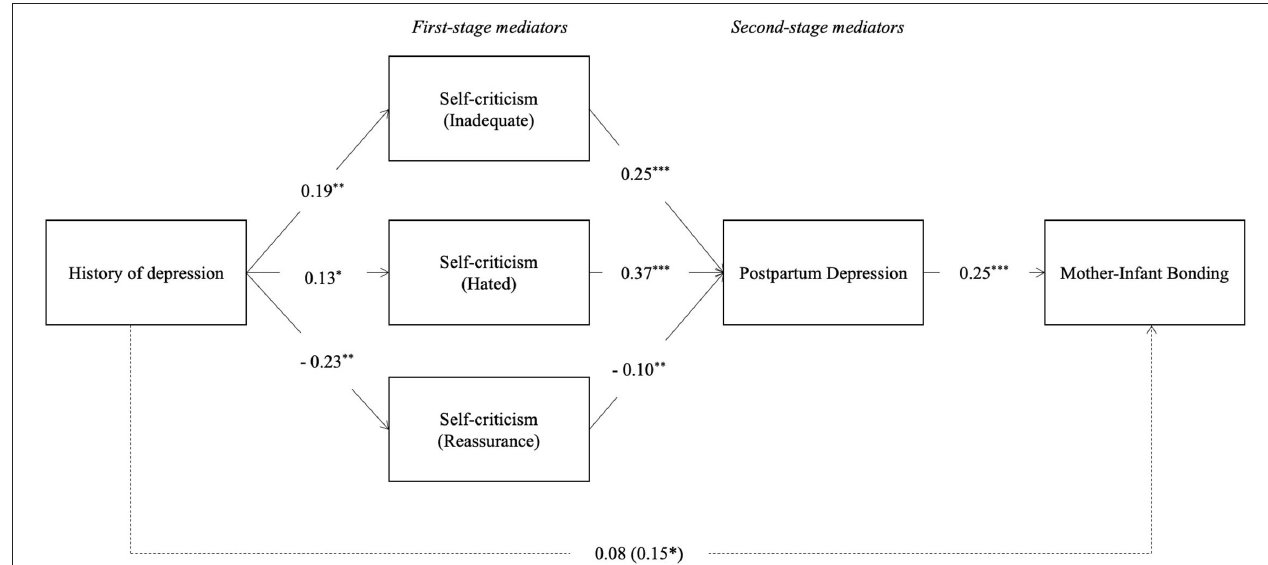
FIGURE 3 | Serial–parallel mediation model with standardized path coefficients: History of depression symptoms, inadequate-self, hated-self and reassuring-self dimensions of self-criticism, PPD Symptoms and mother–infant bonding (M1). * p < 0.05, ** p < 0.01, *** p < 0.001. The coefficients of the total effects appear in parentheses. Dashed lines are not-significant paths.